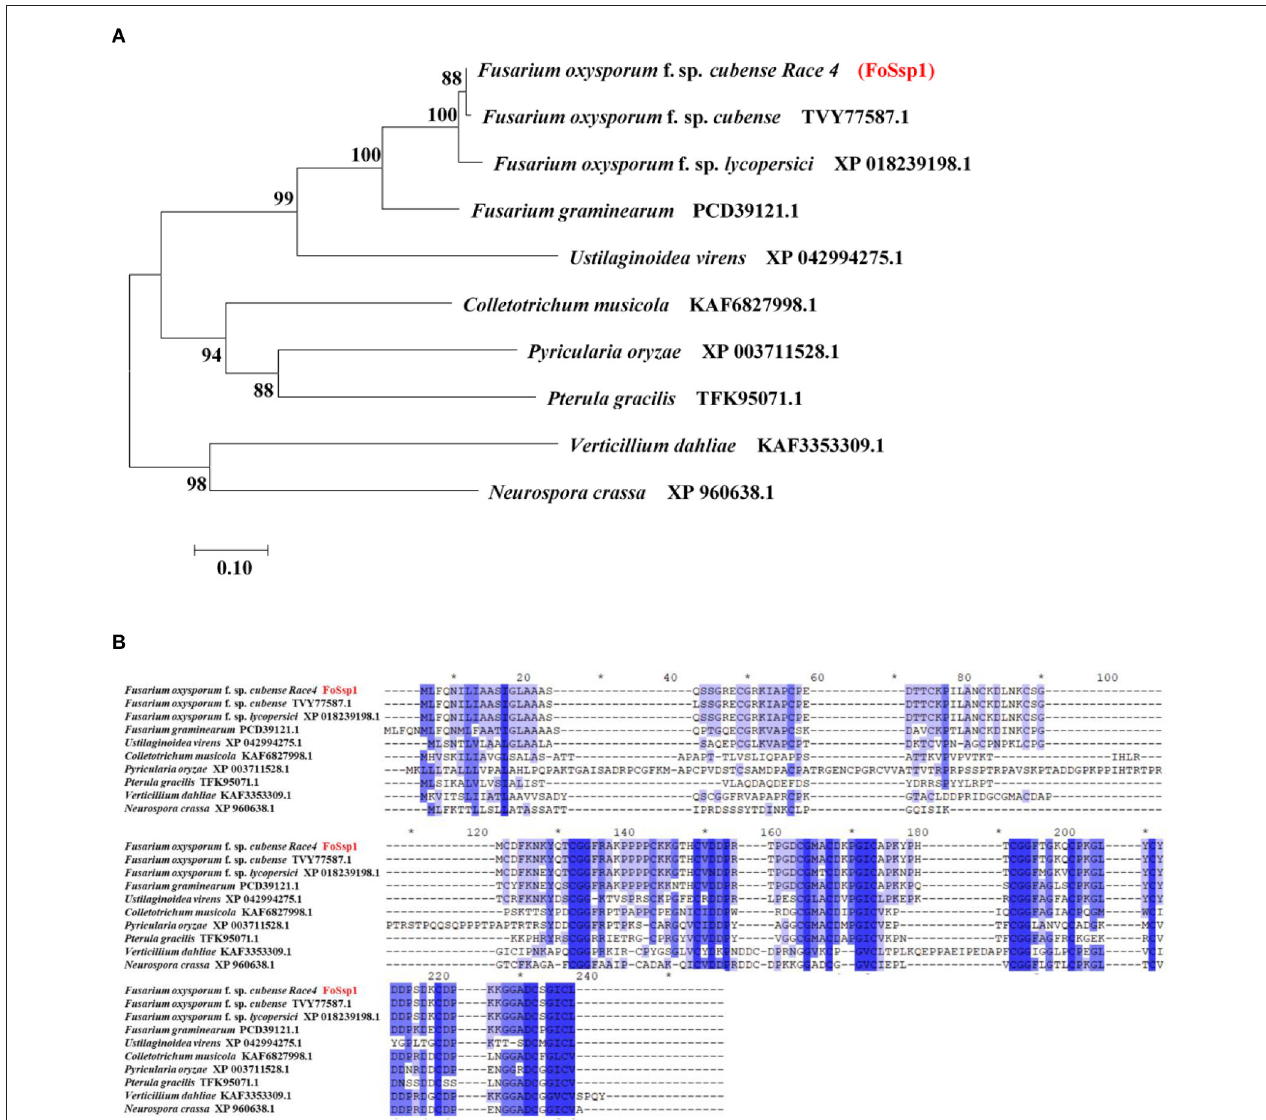
FIGURE 1 | Homology analysis of Ssp1 protein among filamentous fungi. (A) The unrooted tree of full-length protein was generated with the MEGA7 program by the neighbor-joining method. Numbers on major branches indicate percentage boot strap confident scores (1,000 replications). The genetic distance corresponding to the scale is 0.10. (B) Comparative analysis of protein sequences of FoSsp1 and its homologous proteins. The protein sequences were compared and edited with GeneDoc, and the different shades of blue reflected the level of amino acid identity at each location. Identical and conserved catalytic residues are marked with an asterisk ( *